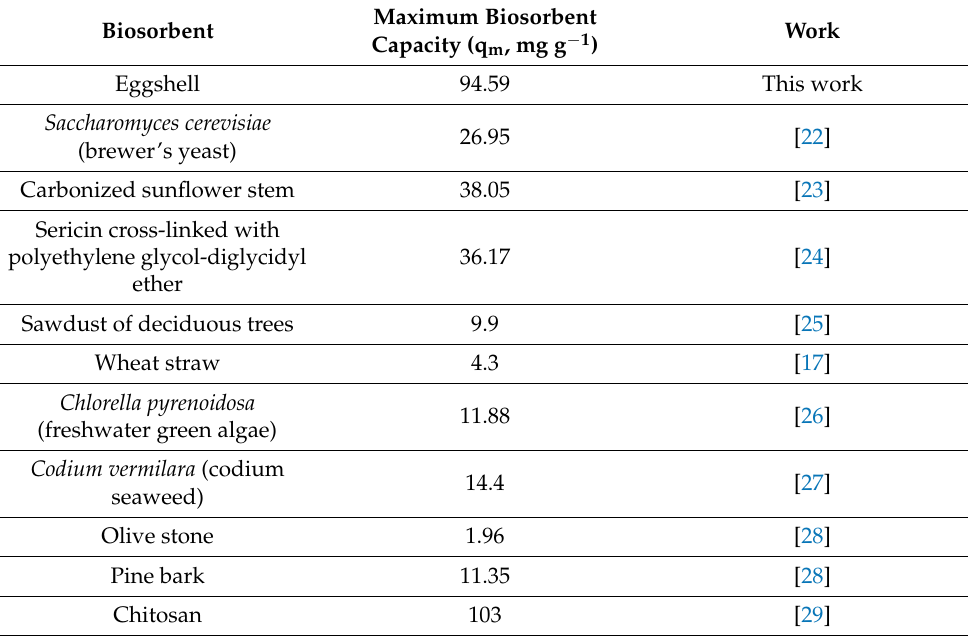
Table 3. Cu 2+ ions biosorption on eggshell in comparison with other